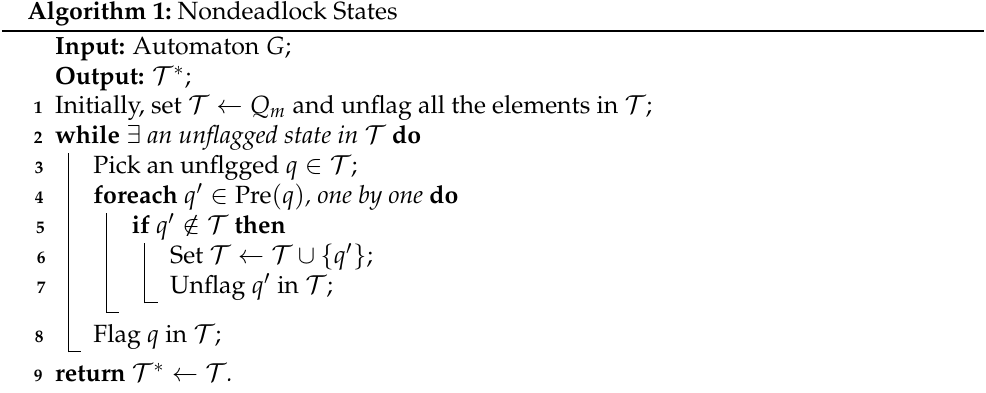
Algorithm 1 calculates all the nondeadlock states Q \ Q dead of G . Algorithm 1: Nondeadlock